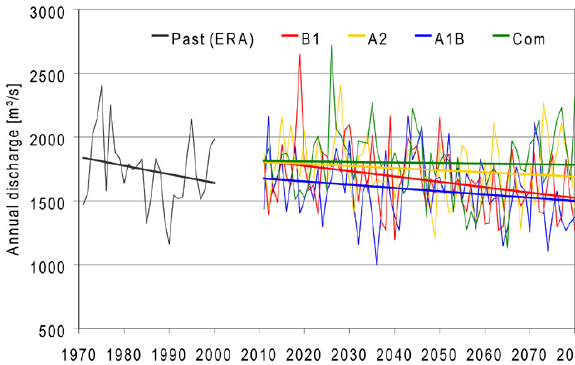
Figure 9. Development of the mean annual discharge in the UDRB for the past and the four scenarios from 1971–2080.